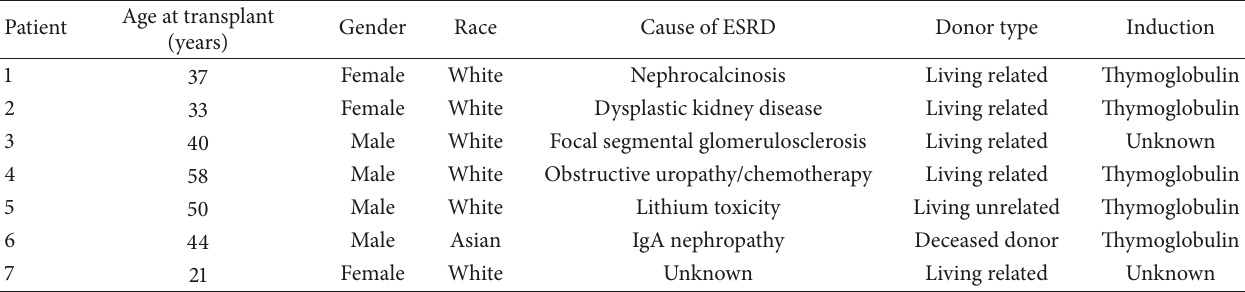
Table 1: Patient characteristics.